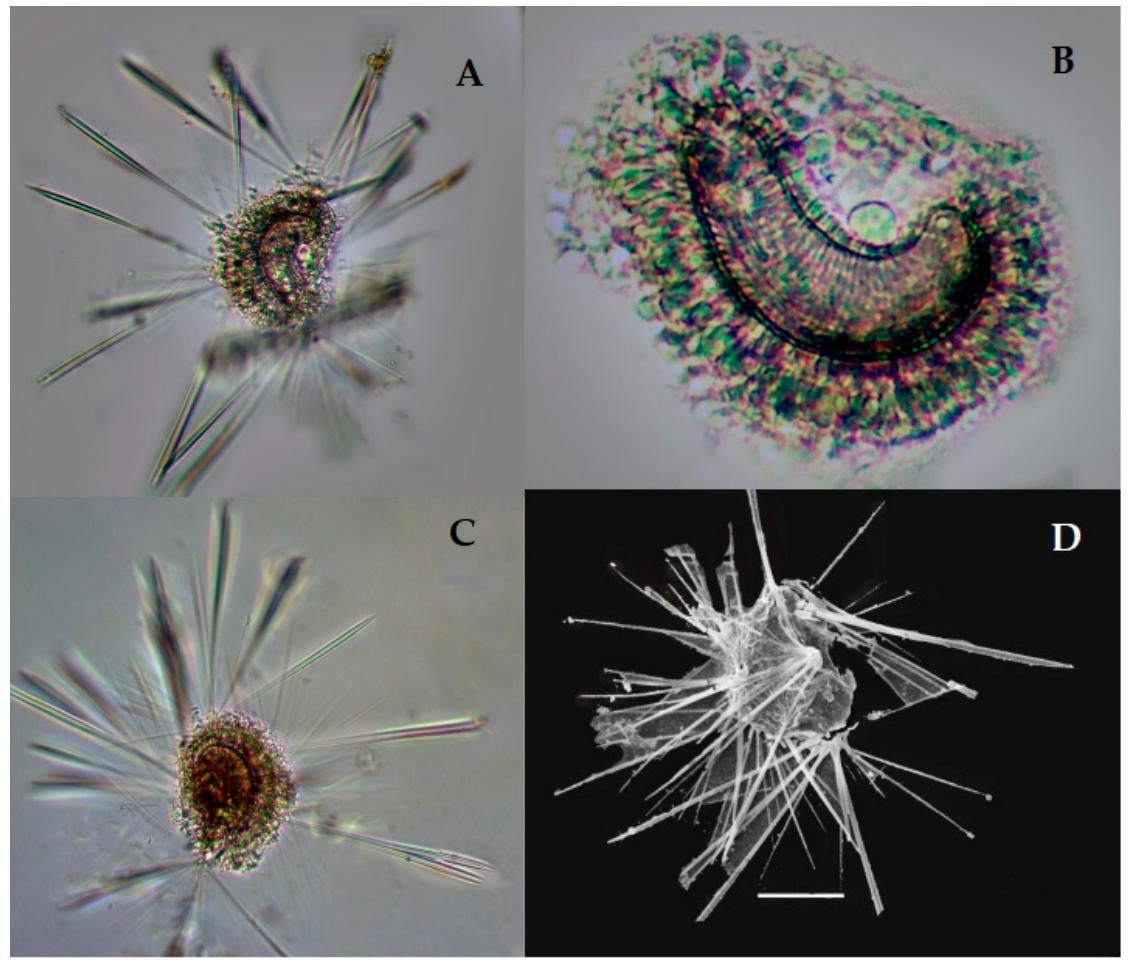
Figure 3. Photomicrographs of Stichonchlea zanchlea -Taxopodida ( A – D ). The images were modified from the Munir et al. [27] ( A , C , D ) complete cell showing the nuclear-with Oar-thick spines. ( B ) Cell showing nucleus with the axonemes at the central point. ( D ) SEM of thick, Oar-like axopodia spines. Scale bars: 10 µm − 50 µm.